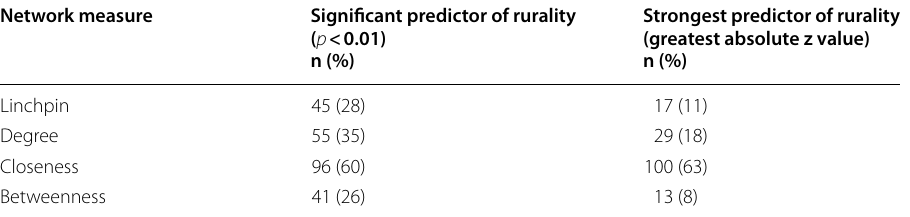
Table 2 Number of hospital referral regions for which each network measure significantly predicts physician rurality Network